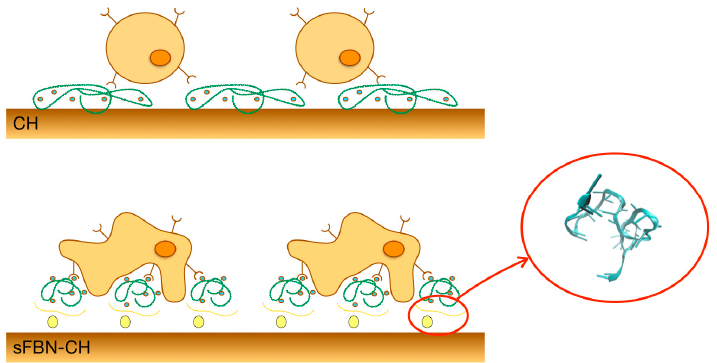
Figure 1. Diagram representing the rationale for the aptamer-coated scaffold to retain fibronectin in a suitable geometric conformation. Un-coated scaffold (CH) adsorbs fibronectin from the surrounding milieu, mostly inducing the masking of cell binding domains. Aptamers specifically lead the adsorption of fibronectin (sFBN-CH) and enrich scaffold with docking points for effective cell adhesion. The 3D rendering of the anti-fibronectin aptamer is a courtesy of Base Pair Biotechnologies (Pearland, TX, USA).